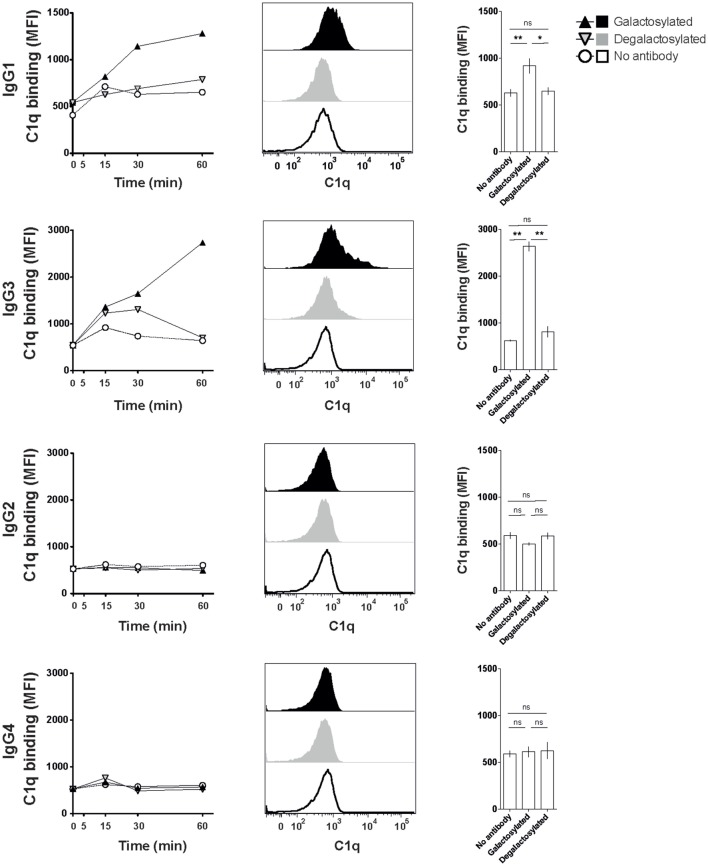
Increased C1q binding of Fc-galactosylated rituximab-derived immunoglobulin gamma 1 (IgG1) and IgG3. Kinetic of C1q binding to CD20+ Raji cells in the presence of galactosylated or degalactosylated glycovariants of human IgG1–4. Exemplary C1q-binding curves (left), flow cytometry histograms of C1q binding after 60 min (center) and statistics at time point 60 min of at least three independent experiments. Statistical analysis: unpaired two-tailed Student’s t-test, mean ± SEM, ns, not significant, *p < 0.05, **p < 0.01, and ***p < 0.001. MFI, median fluorescence intensity.